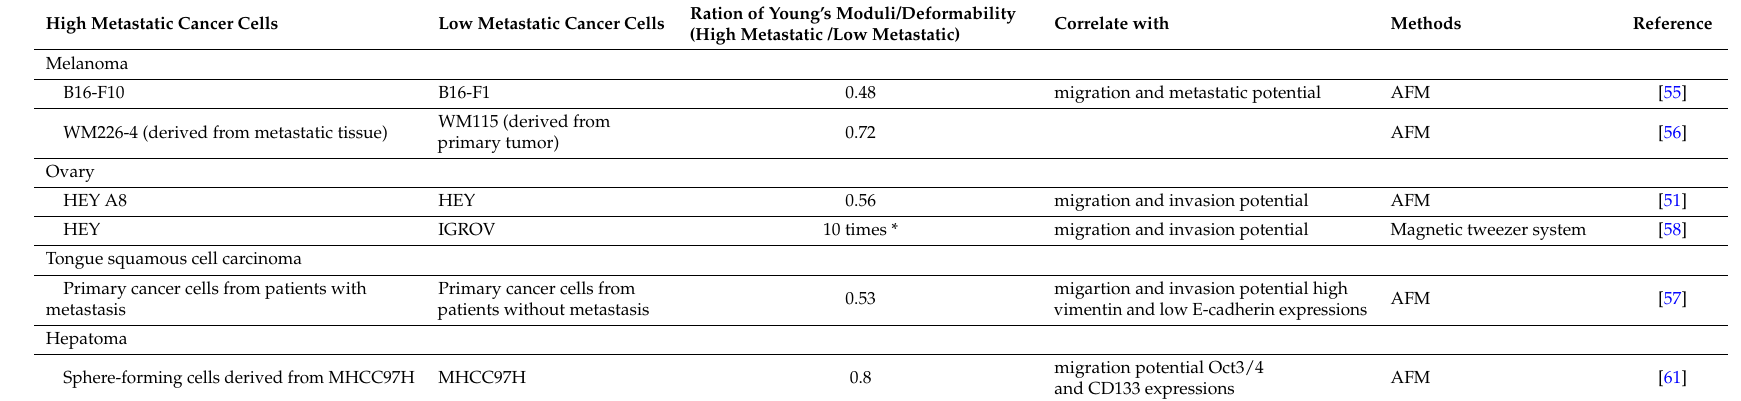
Table 4. Low average value of Young’s moduli indicating low stiffness shown in high metastatic cancer